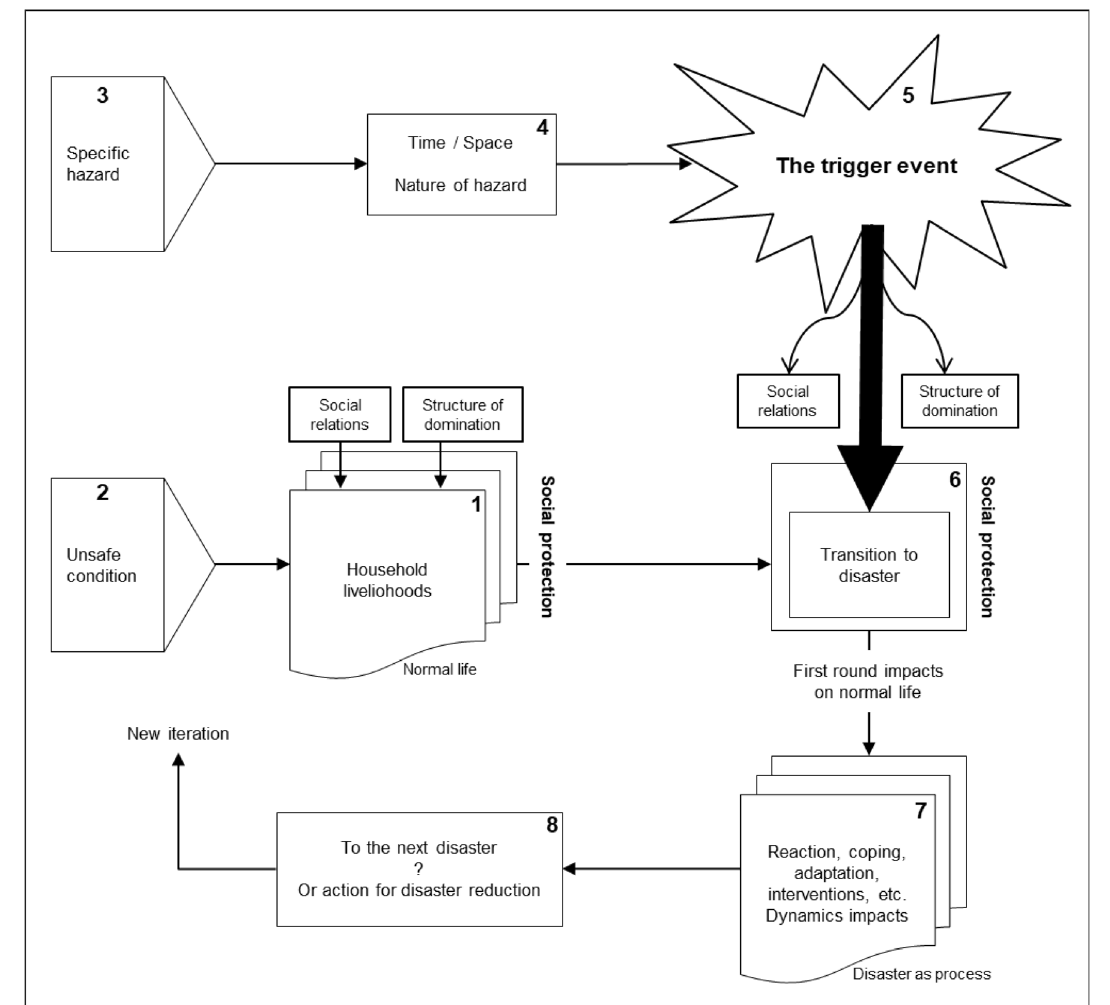
Fig. 4 The Access model. Source Adapted from Wisner et al. (2004)